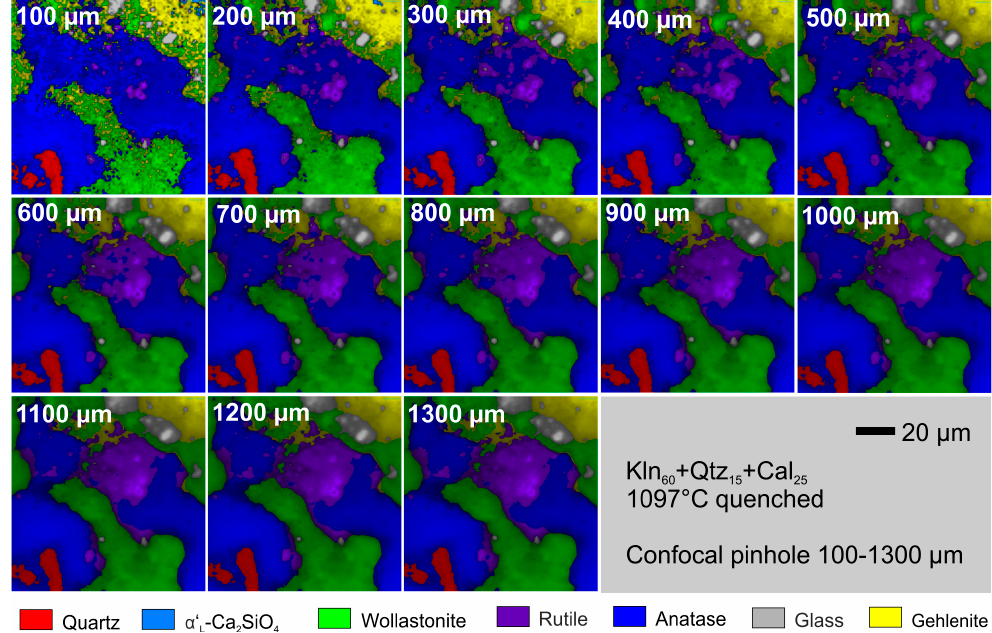
larger than about 800 µm.